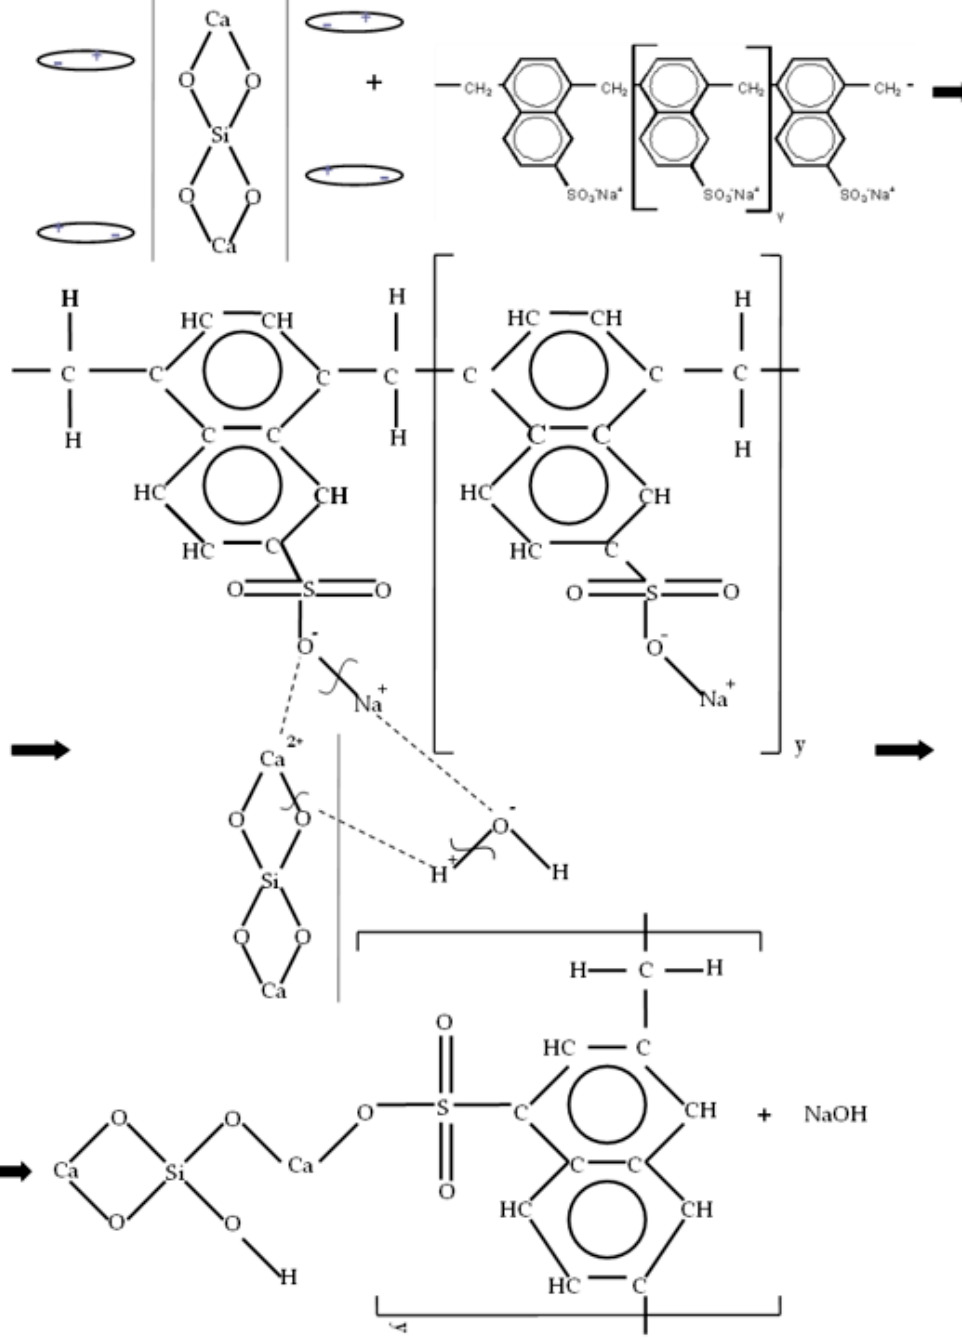
Figure 12. The mechanism of stabilization of slag with a plasticizer.